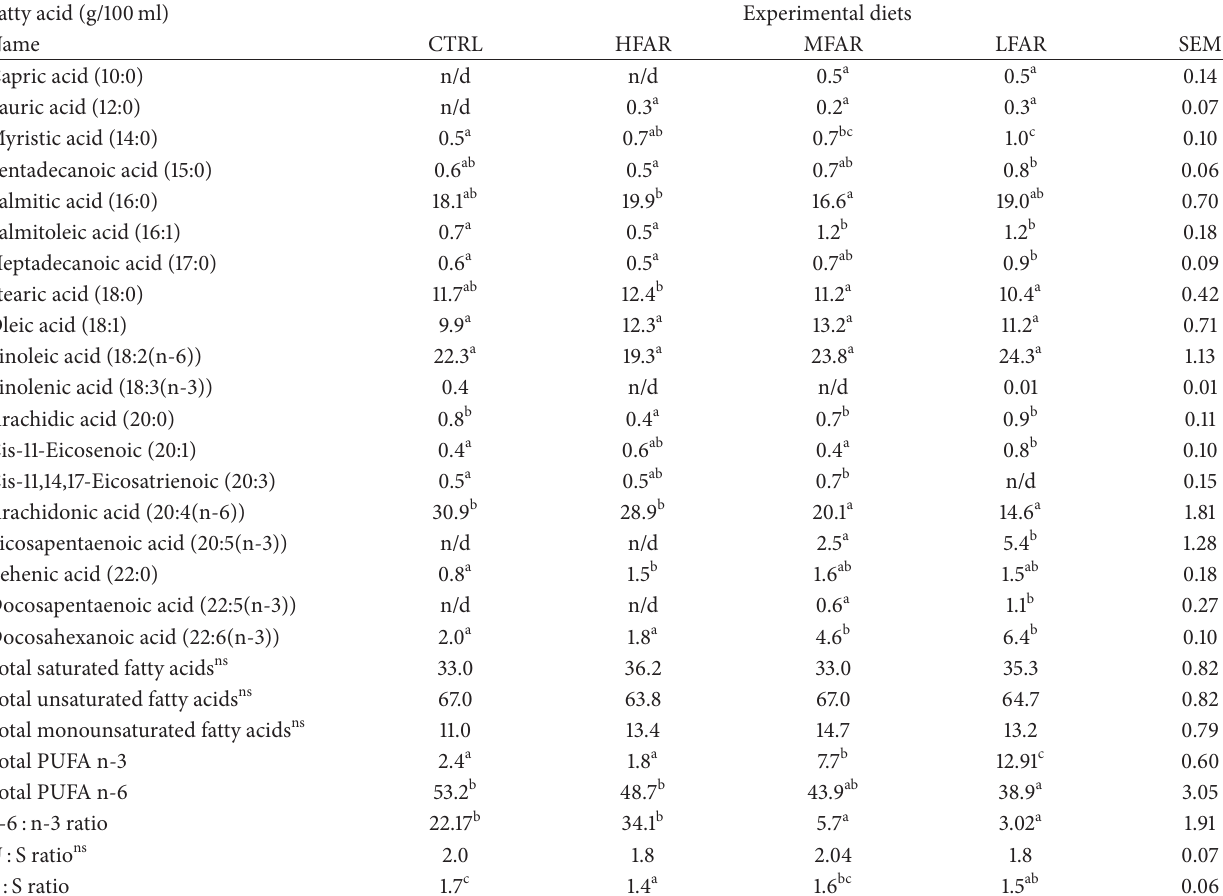
Table 2: Plasma fatty acid profile of treatment